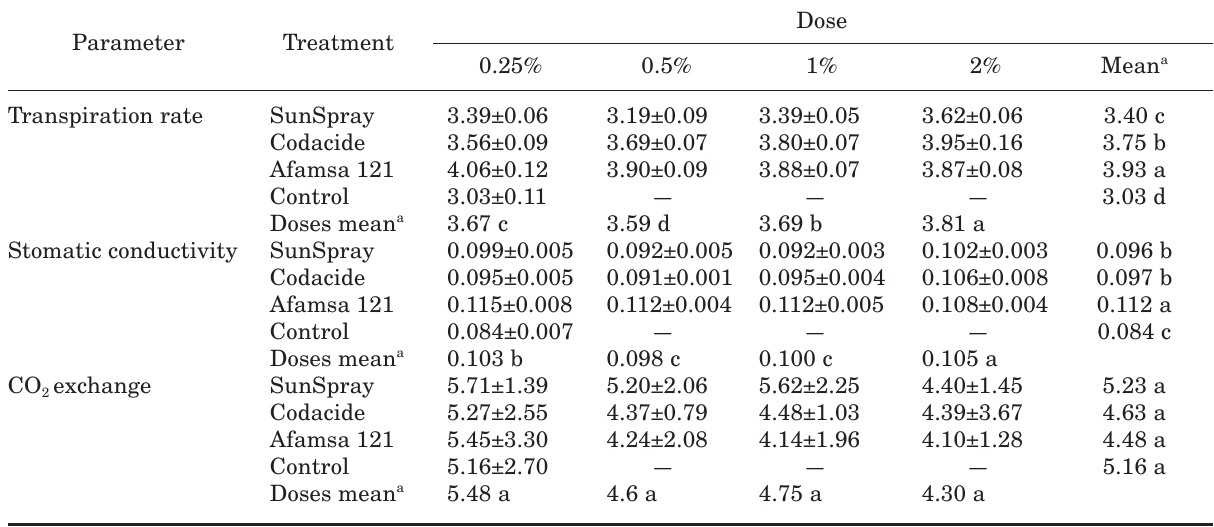
Table 1. Mean and standard deviations of the parameters analysed in the field phytotoxicity assay, one week after the fourth treatment. Transpiration rate in mol/(m 2 ·seg), stomatic conductivity in mol/(m·seg) and CO µmol/(m 2